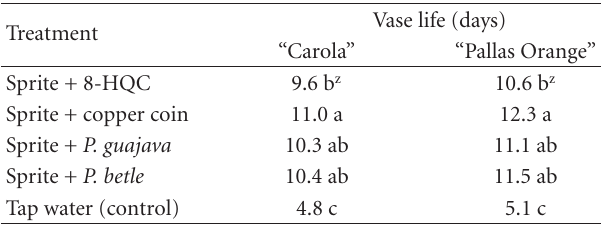
Table 2: E ff ect of 8-HQC, copper coin, and leaf extracts of P. guajava and P. betle and control on vase life of “Carola” and “Pallas Orange” cut carnation